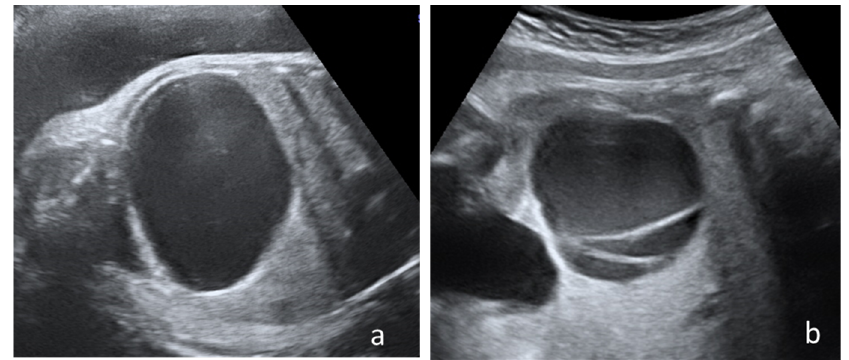
Figure 1. Cyst’s classification according to Nussbaum criteria: ( a ) Simple cyst with thin wall and anechoic aspect, ( b ) complex cyst with intracystic septation.